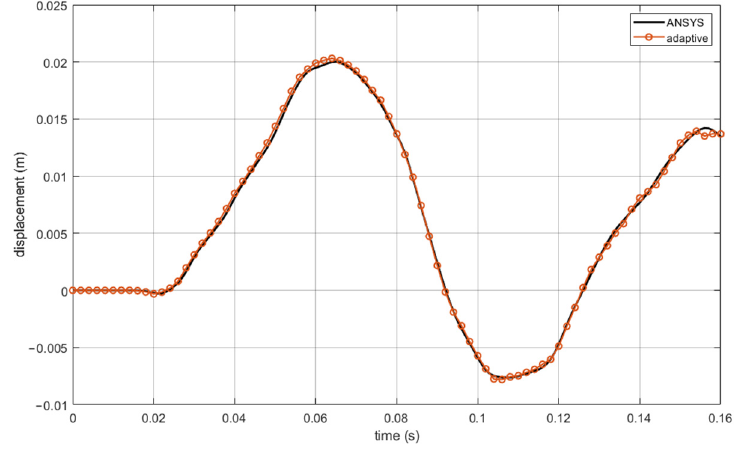
Figure 31. The transient vertical displacement at point A, Δ𝑡 = 0.001 s and 𝑐 = 1 Ns/m for the Heaviside tension step loading.